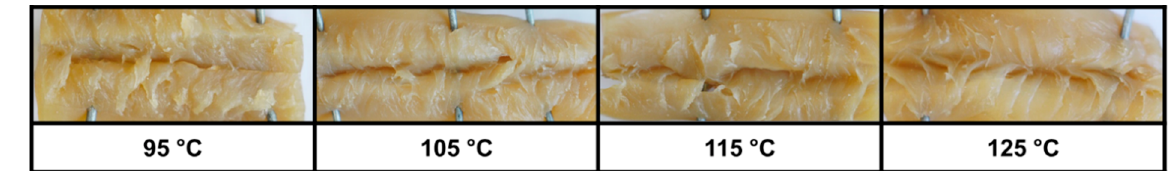
Figure 4. Product structure of the extrudates at the four different investigated material temperatures.